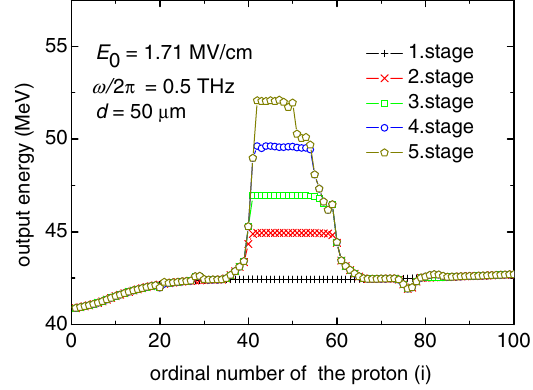
FIG. 6 . Trajectory of protons with initial transversal offset. The inset shows the longitudinal velocity distribution when trans- versal forces are taken into account (solid line), and when they are neglected (dashed line).